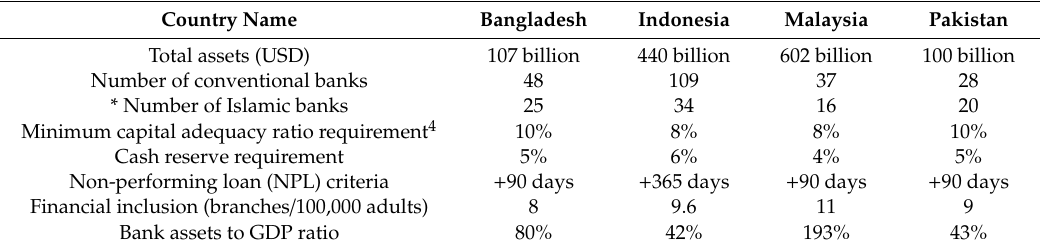
Table 1. Regulatory and institutional characteristics of banking systems in small emerging